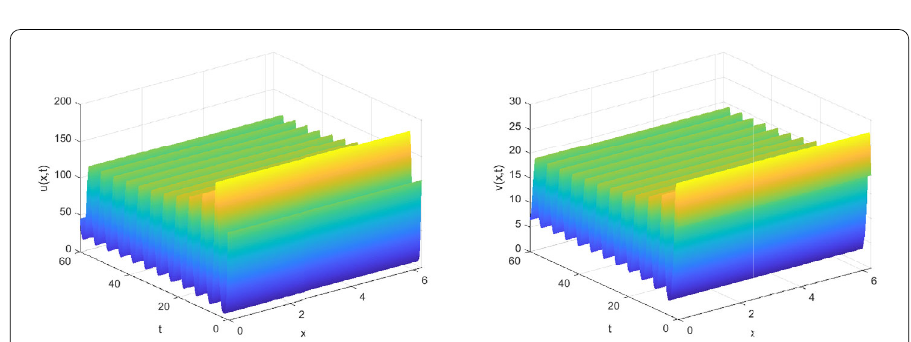
Figure 6 τ = 0.3 > τ 0 0 and the initial condition is (117.47,18.78). The system produces periodic